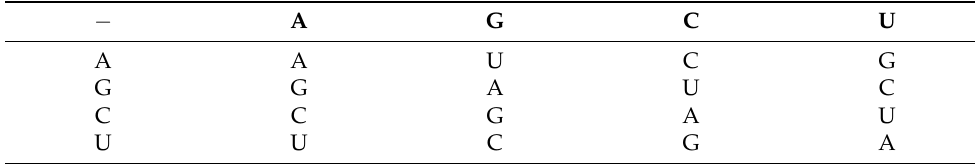
Table 4. RNA subtraction rule.